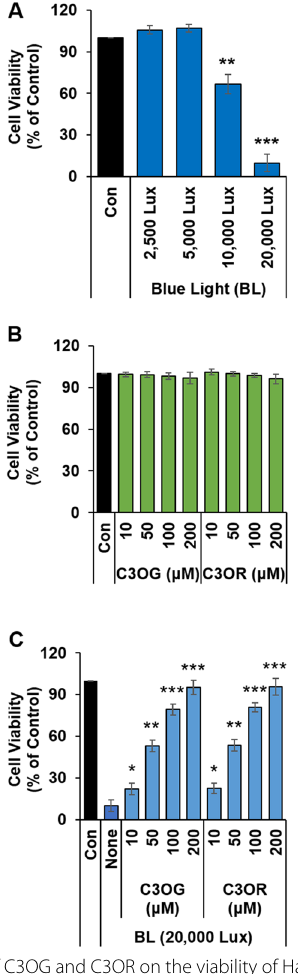
Fig. 1 Effects of C3OG and C3OR on the viability of HaCaT cells exposed to blue light. A HaCaT cells cultured in 96‑well plates were exposed to blue light for 1 h. After 24 h, cell viability was quantified using an MTT assay ( n 3, SD). ** p < 0.01 and *** p < 0.001 vs. = ± the control. B Cells were treated with or without the indicated concentrations of C3OG or C3OR for 24 h, and then cell viability was quantified using an MTT assay ( n 3, SD). C Cells were pre‑treated = ± with or without the indicated concentrations of C3OG or C3OR for 24 h prior to blue light exposure for 1 h. After 24 h, cell viability was quantified using an MTT assay ( n 3, SD). * p < 0.05, ** p < 0.01, and = ± *** p < 0.001 vs. blue light (20,000